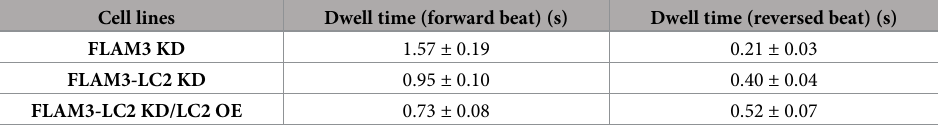
Table 1. Characteristic beating mode dwell times. Dwell time is the fit parameter ± the standard error of the fit, obtained by fitting exponential functions to the cumulative probability distributions of the dwell times (Fig